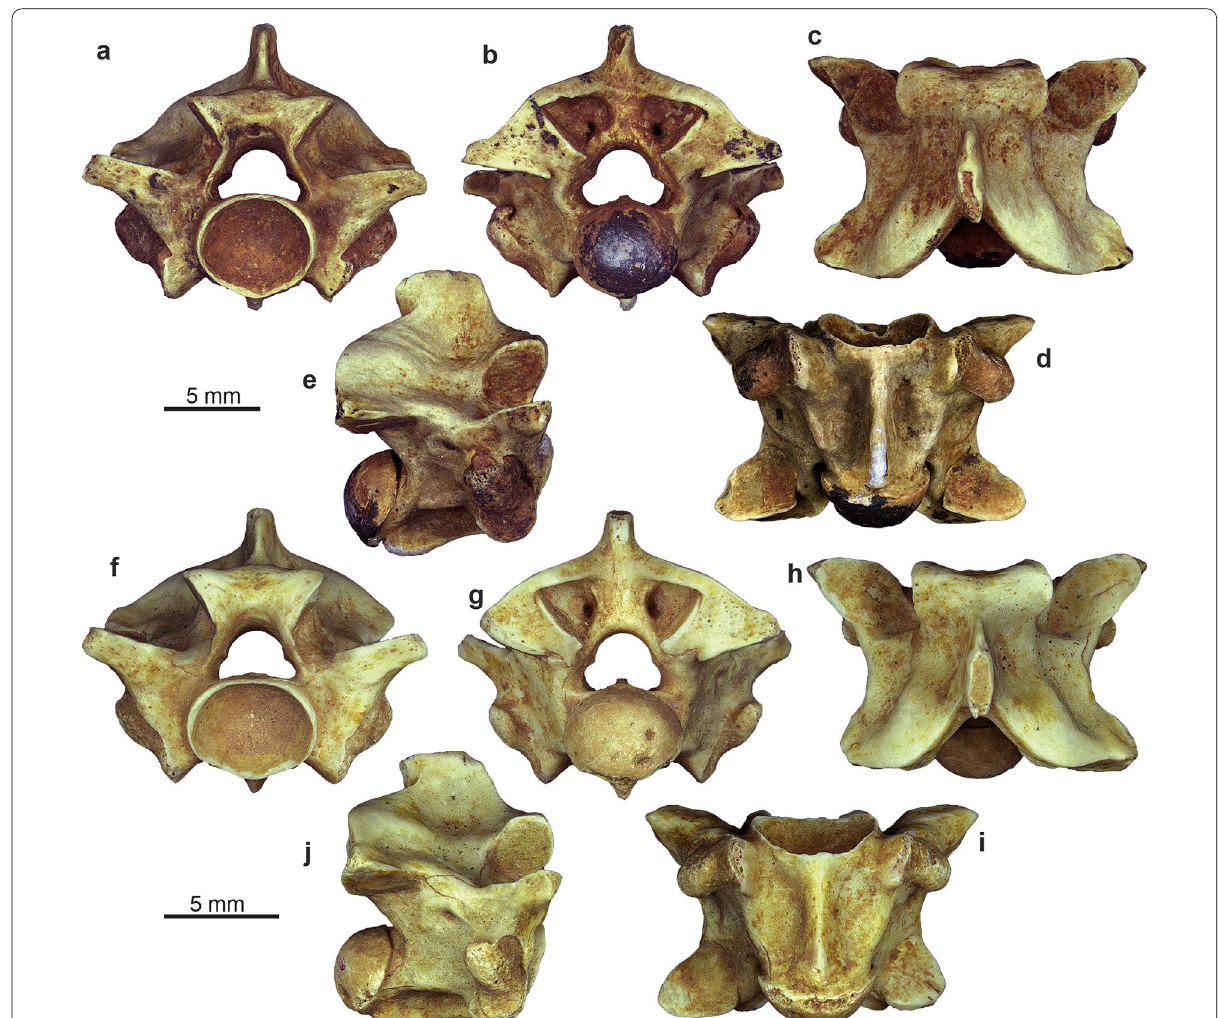
Fig. 85 Phosphoroboa filholii comb. nov. from imprecisely known locality(ies) in the Phosphorites du Quercy: a – e mid-trunk vertebra (NHMW 2019/0033/0056) in anterior ( a ), posterior ( b ), dorsal ( c ), ventral ( d ), and right lateral ( e ) views; f – j mid-trunk vertebra (NHMW 2019/0033/0004) in anterior ( f ), posterior ( g ), dorsal ( h ), ventral ( i ), and right lateral ( j ) views. The former specimen has been figured in Georgalis and